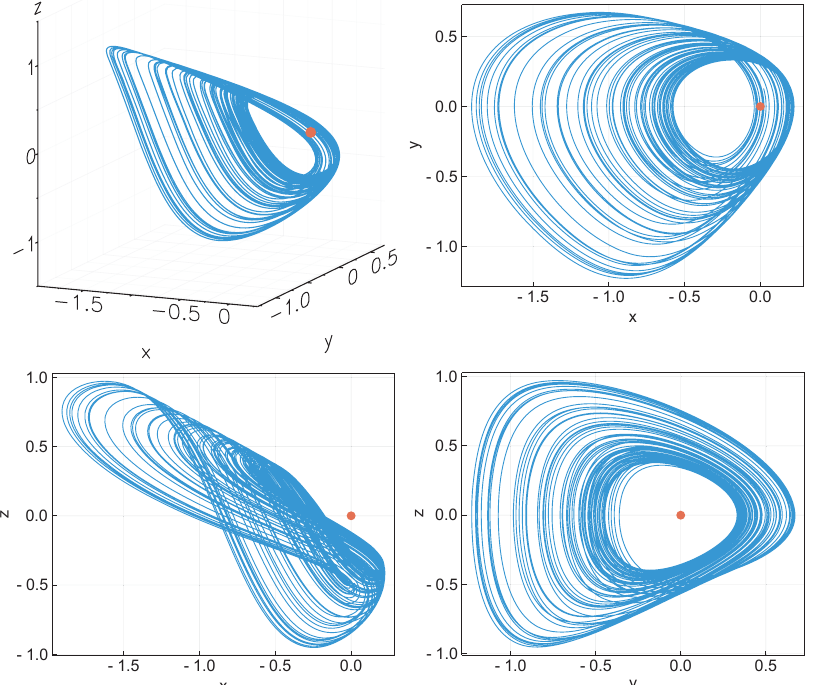
Figure 8. A 3D view of the hidden chaotic attractor (in blue) and point attractor (in red) of system (28) and its various projections. Initial condition that realizes the hidden hidden chaotic attractor: ( x ( 0 ) , y ( 0 ) , z ( 0 )) = ( 0, 1.5,0 ) −